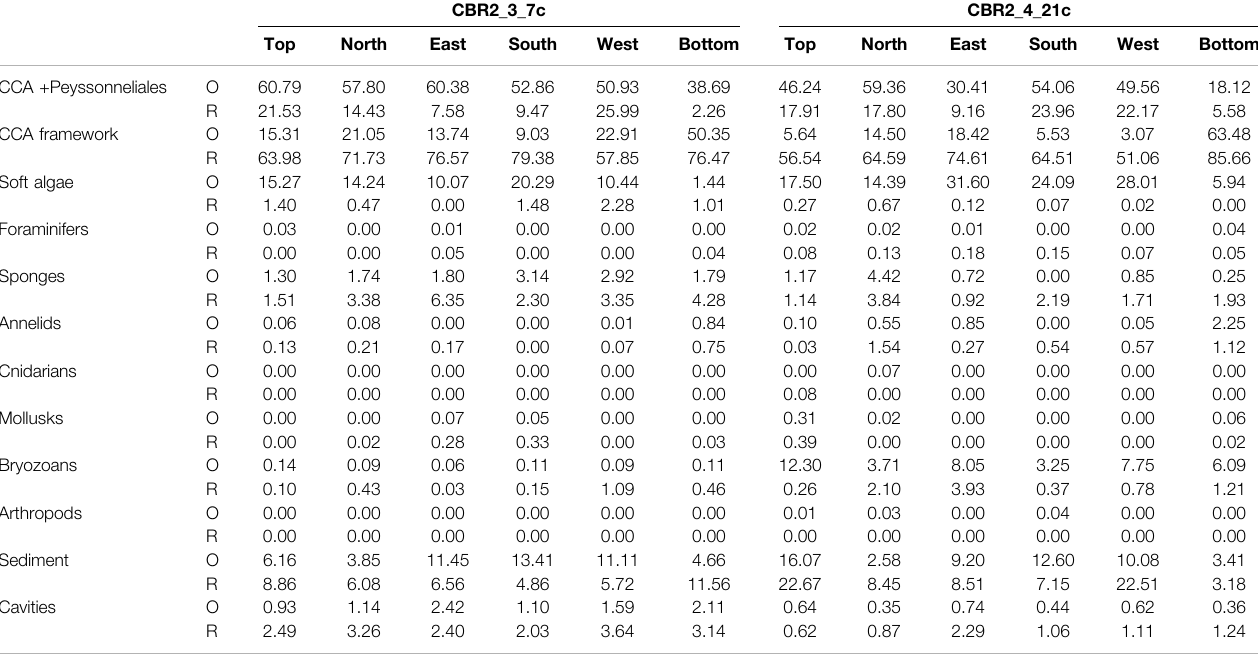
TABLE 1 | Cover of the identi fi ed classes on the surfaces of coralligenous samples CBR2_3_7c and CBR2_4_21c, at time of collection (O = original) and after the canopy removal (R). Results expressed in cover percentages. CBR2_3_7c Top North East Bottom Top Bottom CCA +Peyssonneliales O